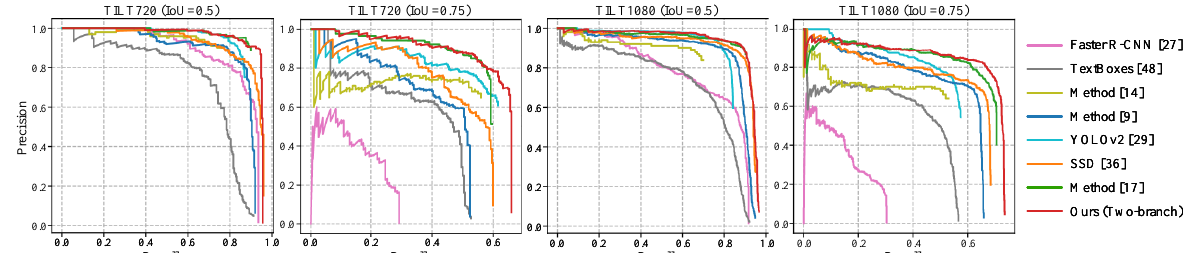
Figure 7. The Precision–Recall curve of different methods. The title of each graph indicates the dataset and IoU threshold for testing. Our method achieves the best performance for all the test sets and IoU thresholds in terms of the area under the curve (AUC). Moreover, our method achieves the best Recall rate, according to the Recall-axis.